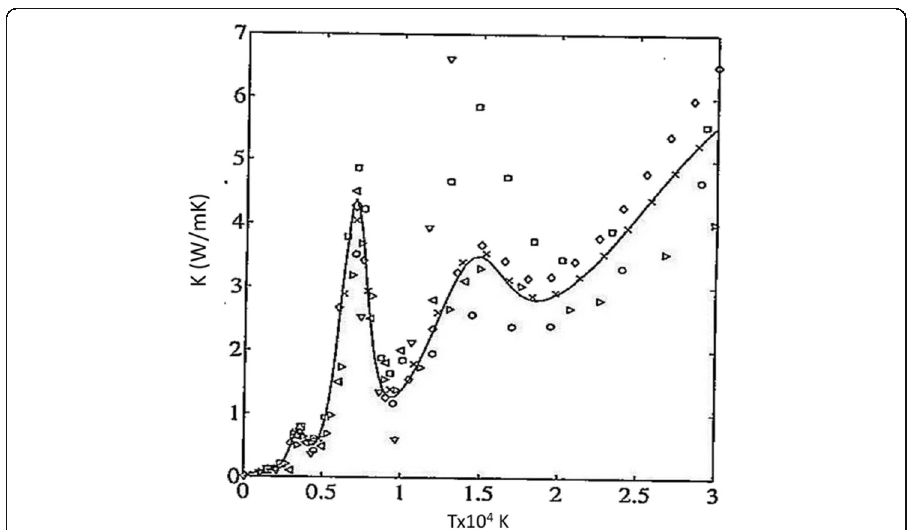
Fig. 17 Thermal conductivity coefficient of equilibrium